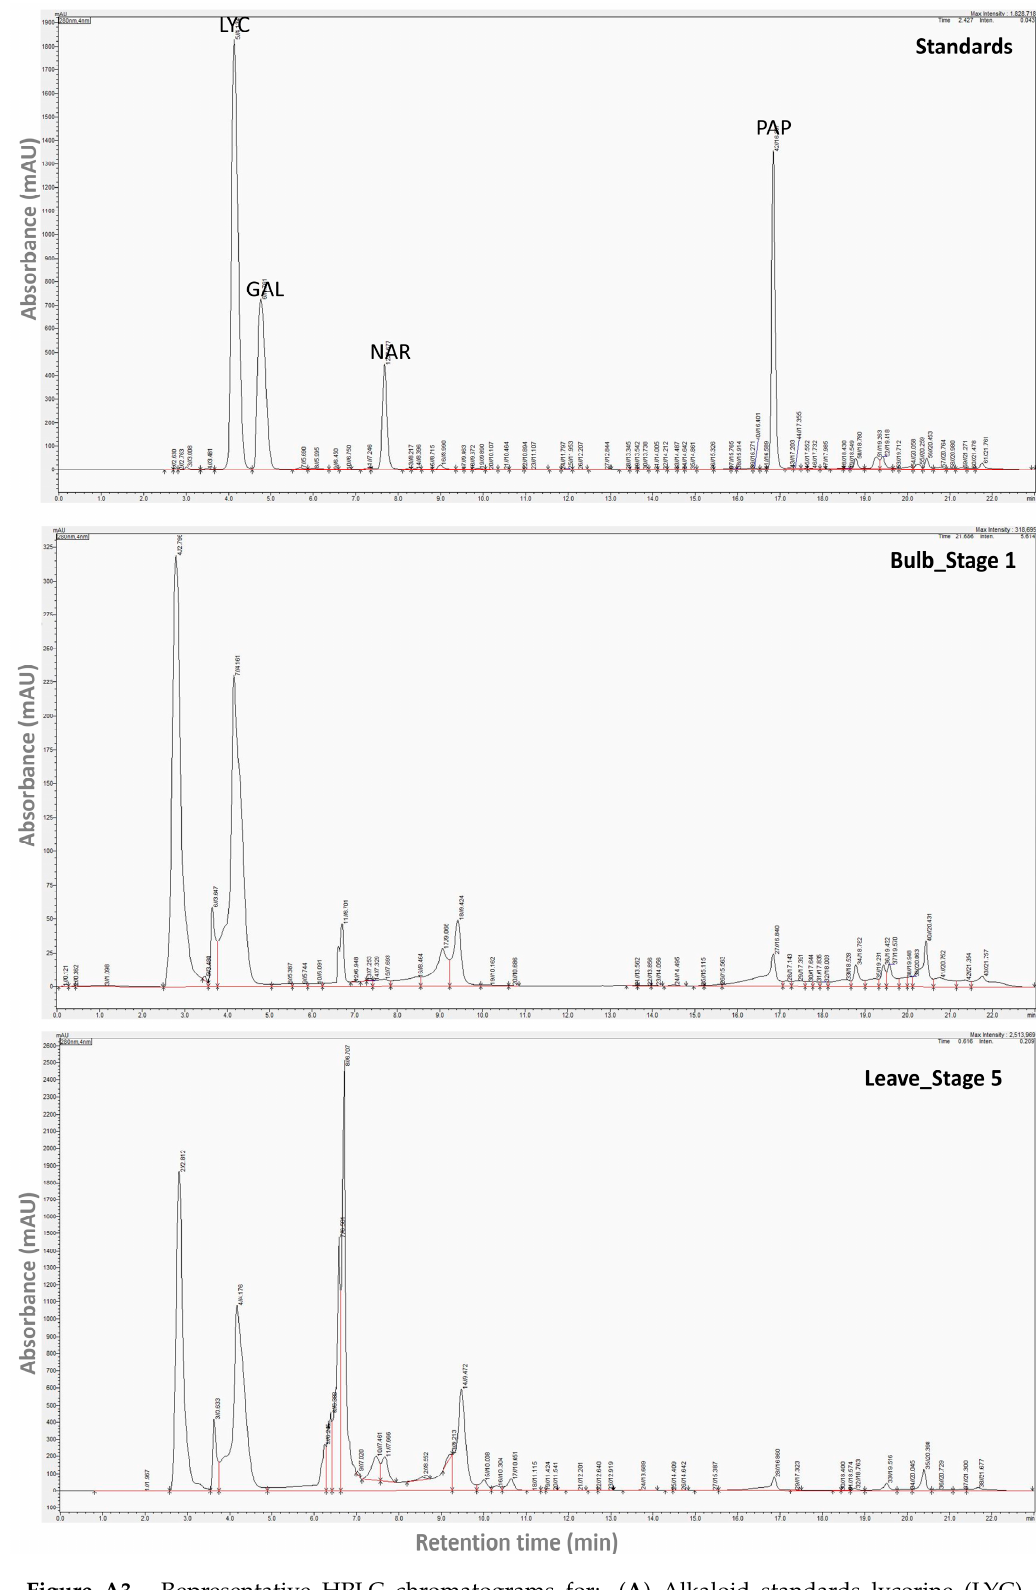
Figure A3. Representative HPLC chromatograms for: ( A ) Alkaloid standards lycorine (LYC), galanthamine (GAL), narciclasine (NAR) and papaverine (PAP); ( B ) heterocyclic compounds extracted from the Narcissus papyraceus stage 1 bulb and ( C ) heterocyclic compounds extracted from the Narcissus papyraceus stage 5